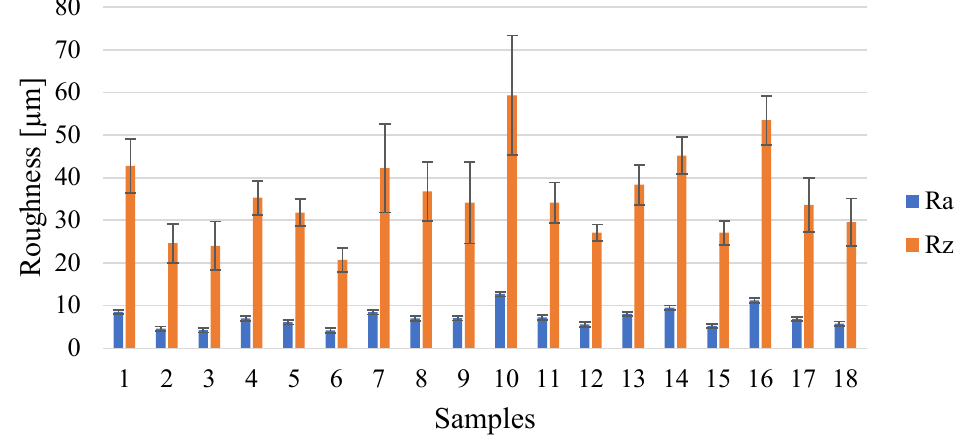
Figure 5. Results of R a [µm] and R z [µm].